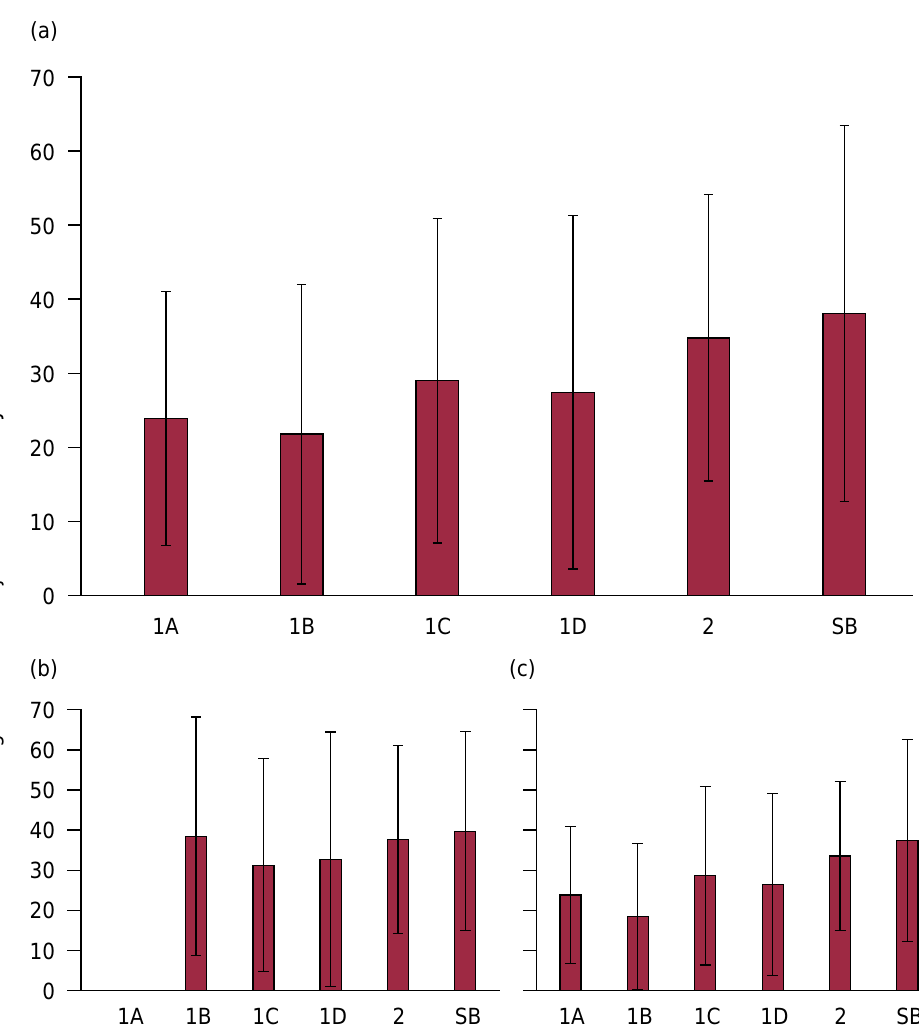
Figure 7. Scientific production index in the last five years (January 2013 to October 2018), by PQ fellowship class and non-fellows (SB), for all researchers regardless of sex (a) and by gender, women (b) and men ( c), in CNPq Call